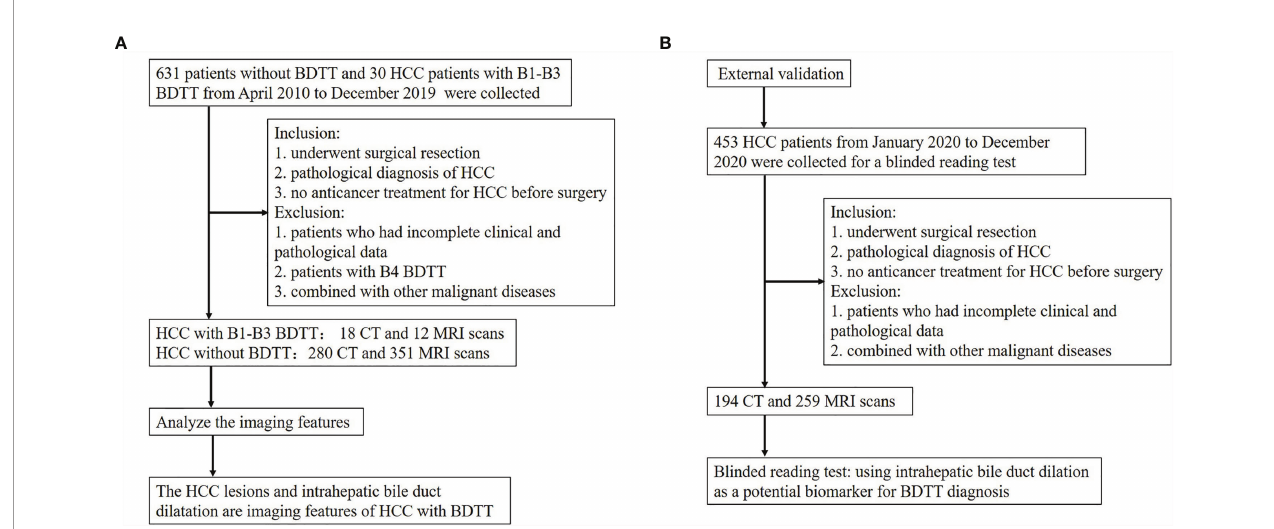
FIGURE 2 | Flow diagram of the study. (A) The fl ow chart of analyzing the imaging features of HCC with B1 – B3 BDTT. (B) The fl ow chart of the external